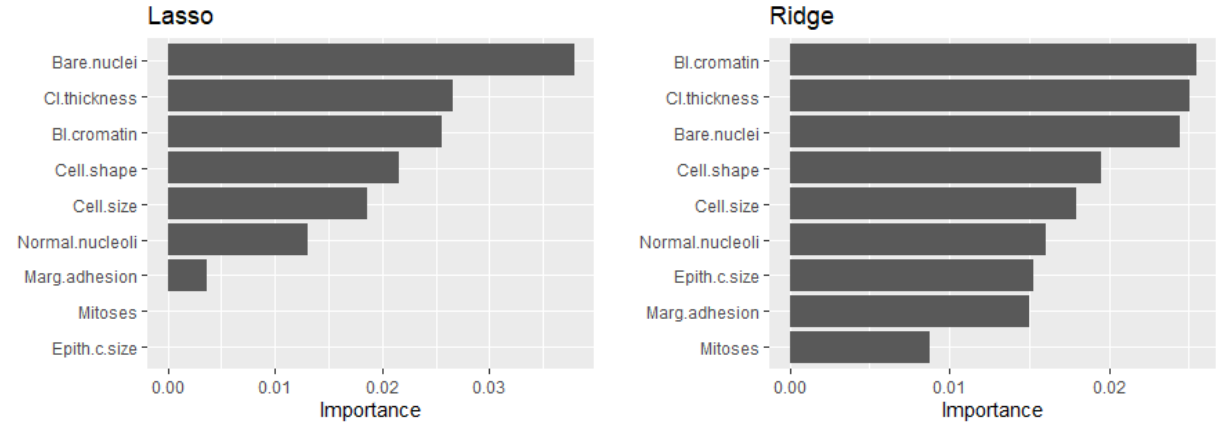
Figure 14. Variables importance plot for lasso and ridge regression for the breast cancer data.